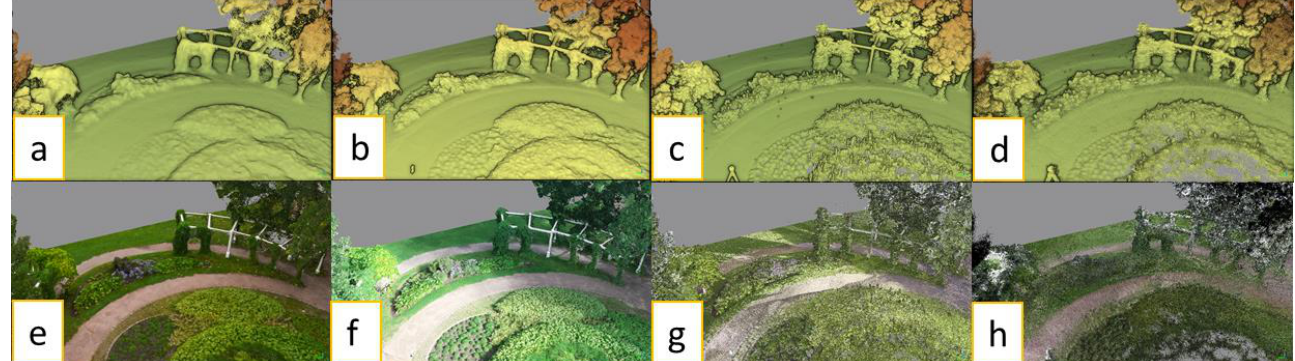
Figure 12. Comparisons of point clouds for perennials, lawns, perennial vines, and semipermeable surfaces: grass stones, and permeable pavements: sand surfaces. In the top row, the point clouds are colored with the height ramp, and in the bottom row with RGB colorization.